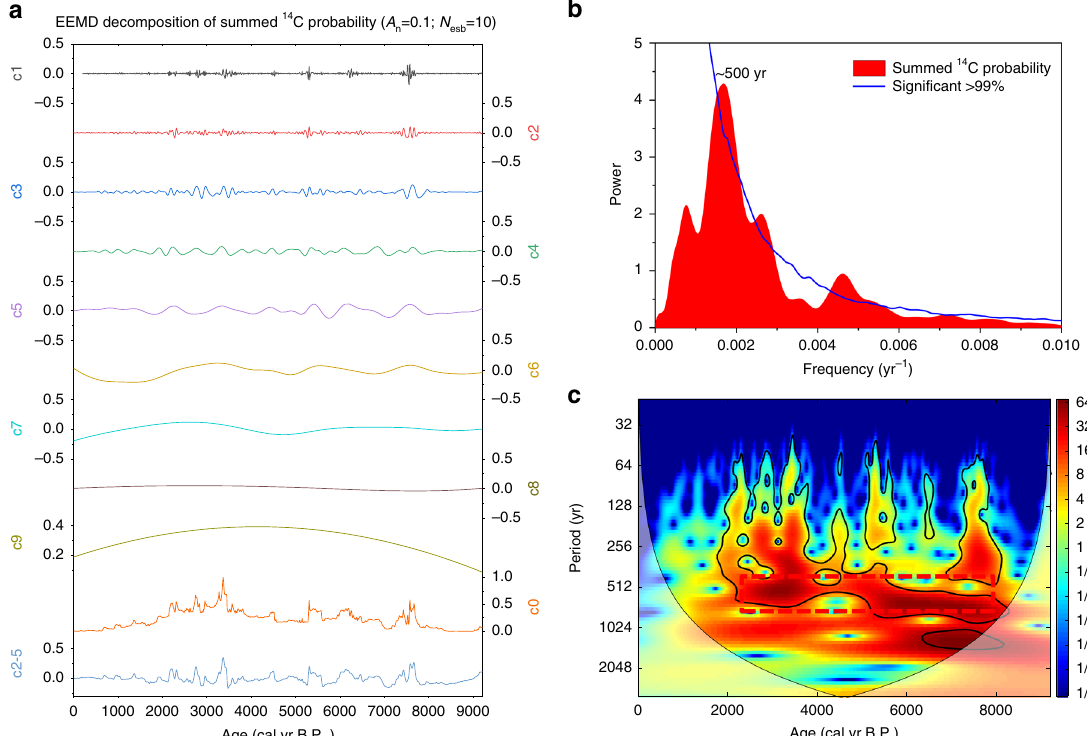
Fig. 4 Results of time-series analysis of the SCP record for NE China. ( a ) EEMD 35,36 : white noise (A n ) of 0.1 and the component number (N esb ) of (cid:1) (cid:3) þ 1 10 (cid:1) Log 922 are used for the fi rst EEMD component. Component c0 represents the original SCP data. To remove high-frequency fl uctuations and 2 orbital and millennial trends, a new detrended time series (c2-5) was formed by summing components c2-c5 from the fi rst decomposition (c0). ( b ) Results of univariate spectral analysis 37 of the SCP time-series over the past 8000 yr. ( c ) Wavelet power spectrum 38 of SCP. The 95% con fi dence level is outlined in black. The red dotted box indicates the strong oscillations of ~ 500-yr cycles during the period of ~ 8000 to 2000 cal yr